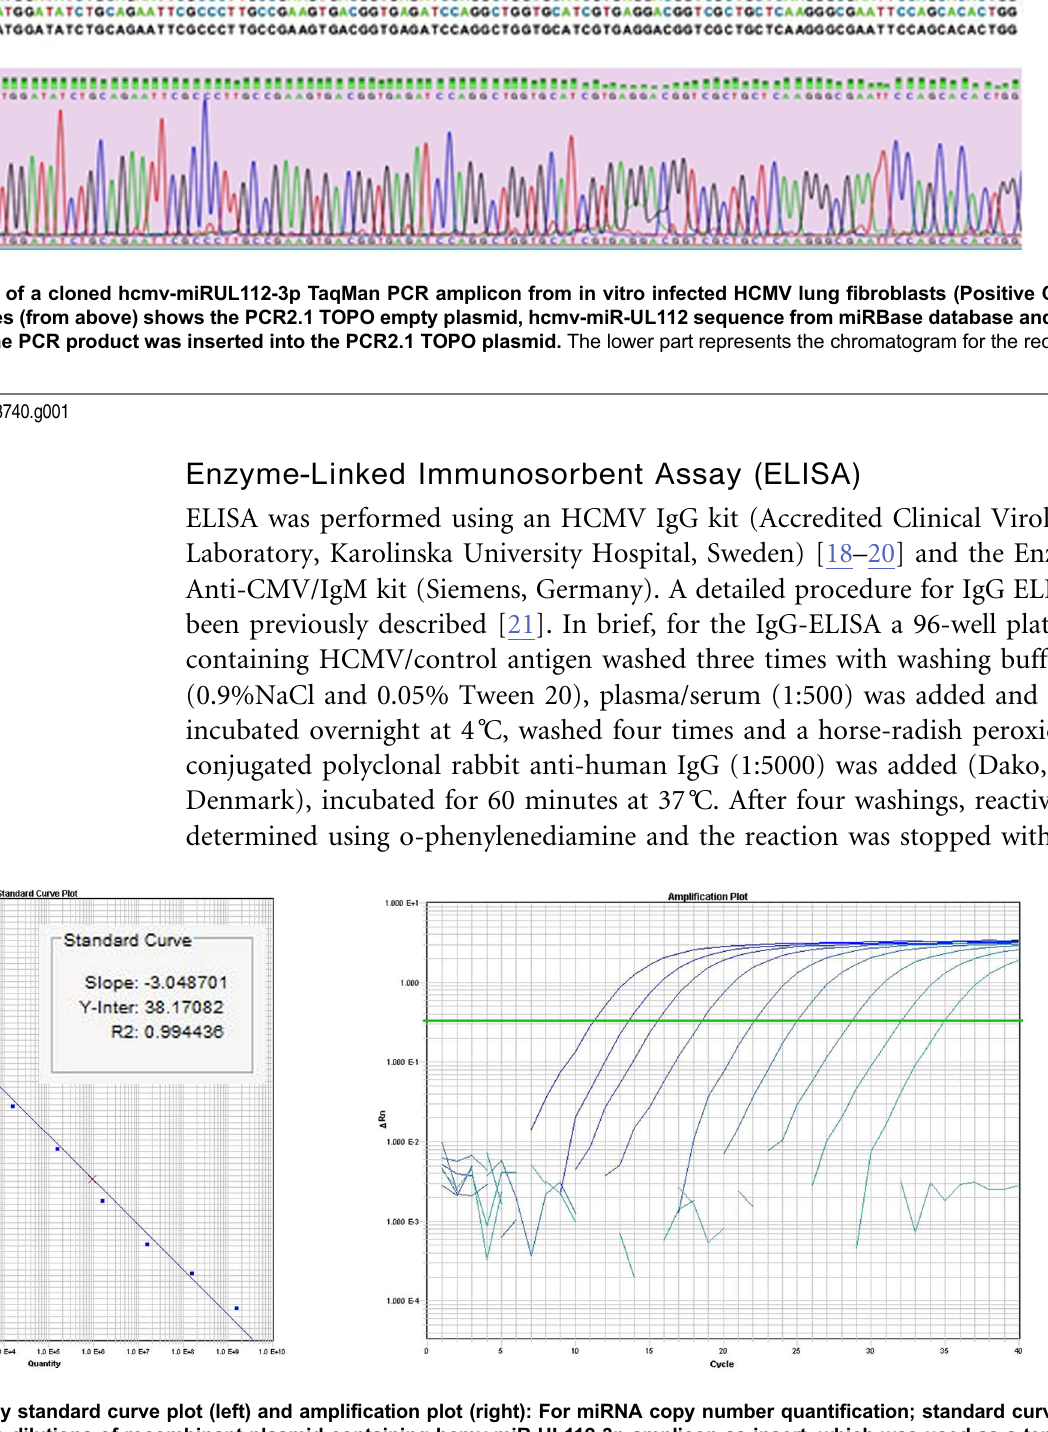
Figure 2. TaqMan assay standard curve plot (left) and amplification plot (right): For miRNA copy number quantification; standard curve was prepared from ten time dilutions of recombinant plasmid containing hcmv-miR-UL112-3p amplicon as insert, which was used as a template in TaqMan miRNA